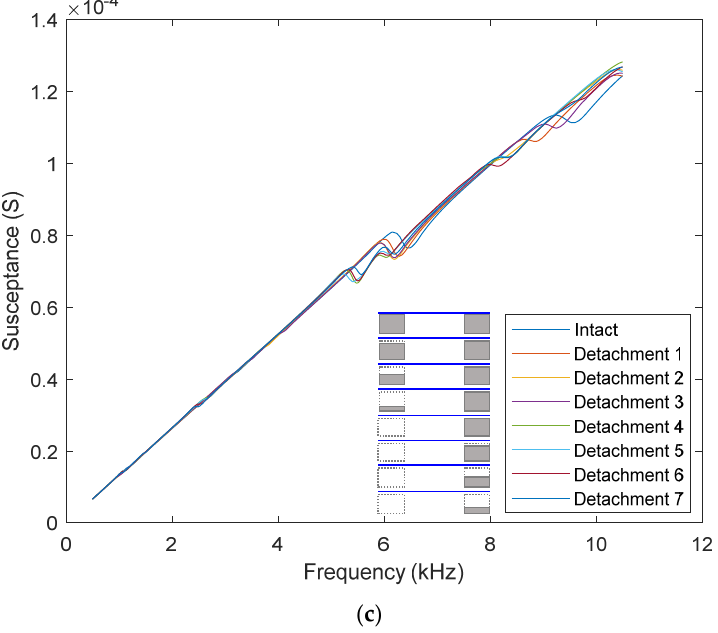
Figure 13. Impedance response: device detachment simulation. ( a ) Resistance; ( b ) Reactance; ( c ) Susceptance.